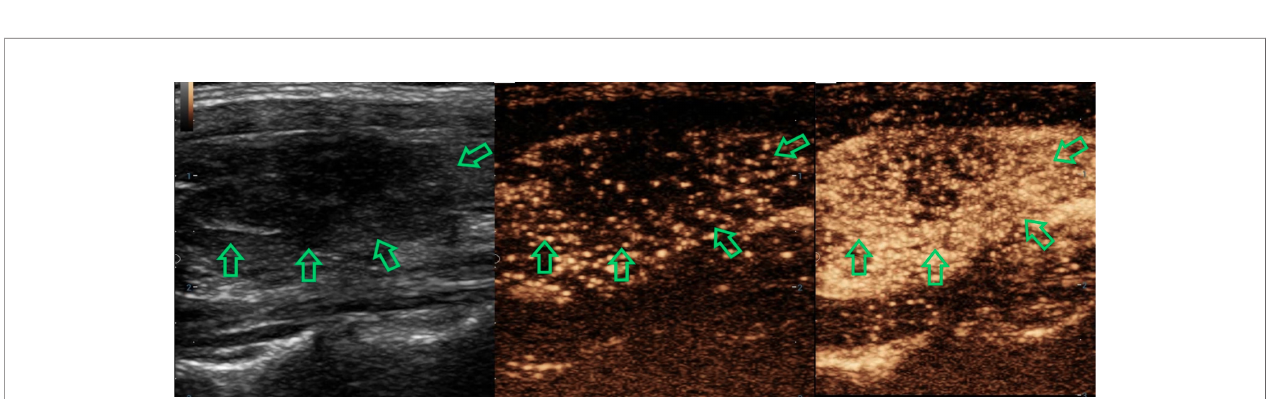
FIGURE 2 | A 38-year-old woman with a nodule in the right-lobe of her thyroid gland. There are two suspicious signs with the nodule (solid and irregular margin) and it was de fi ned as C-TIRADS 4b. In CEUS analysis, it re fl ected as equal arrival time, iso-enhancement, homogeneity, and diffuse enhancement, receiving a score of 0 in the CEUS model. The CEUS-TIRADS category was 4a. The pathological result was Hashimoto ’